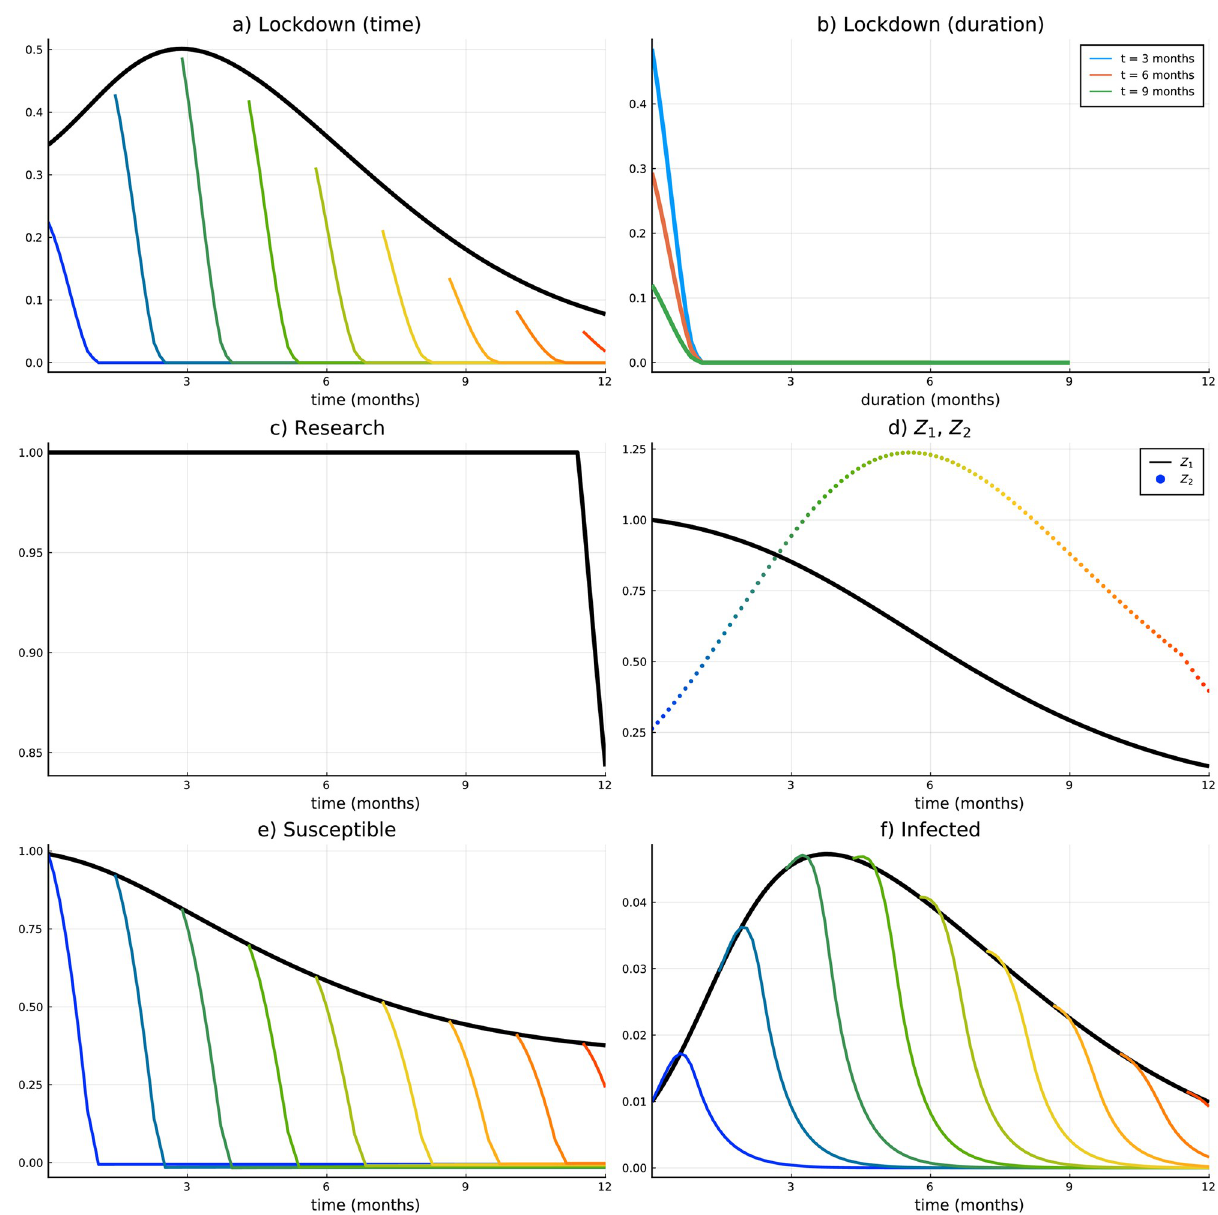
Fig 6. Scenario 2 (Course of the pandemic). (a) Lockdown intensity over time, (b) Lockdown intensity along duration, (c) Research effort over time, (d) Probability that τ has not set in yet, (e) Susceptibles, (f) Infected. The drastic continuous decrease of the lockdown after the vaccine approval in Stage 2 gets obvious in panel (b), showing the lockdown intensity along the duration. As in Scenario 1, the blue line corresponds to the lockdown over time if the vaccine is approved within three months, the red one for approval within six months, and the green one for approval within nine months. In all three cases, we see that the lockdown is ended about one month after the vaccine approval, irrespective of the lockdown intensity at the switch. That means that the lockdown should be ended completely only when almost all people have received the vaccination.